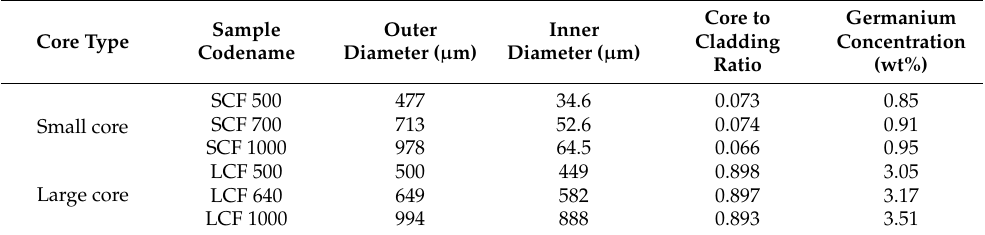
Table 1. Dimensions of the optical fiber scintillator